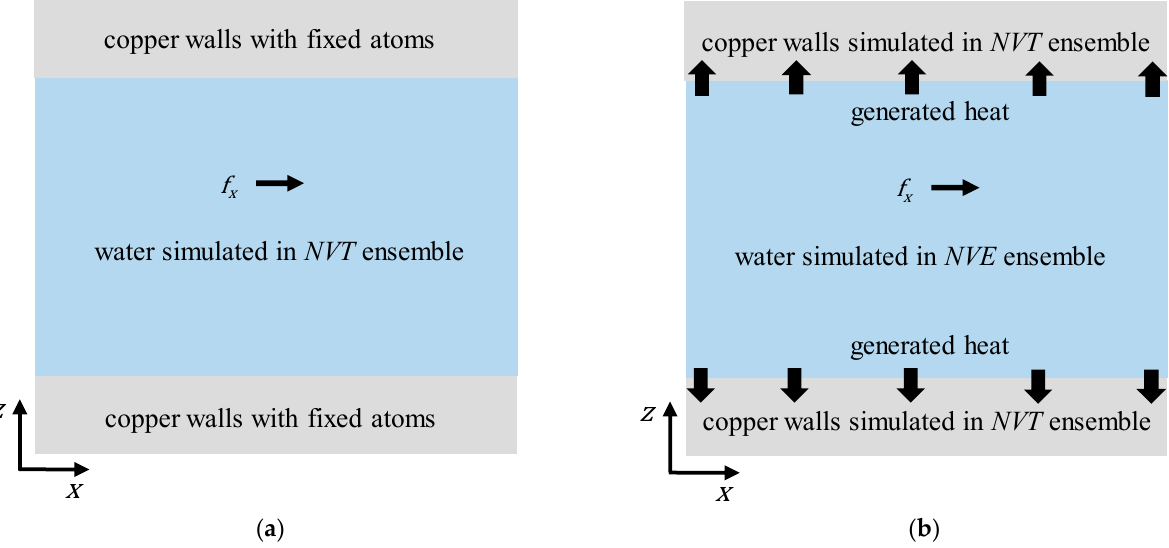
Figure 2. The water flow in planar nanochannel temperature control strategies considered in MD simulations: ( a ) frozen wall (FW) simulations, in which the thermostat was applied directly to the flowing water, and copper wall atoms were frozen, and ( b ) dynamic wall (DW) simulations, in which the dynamics of copper atoms were solved, and the thermostat was applied only to copper walls.